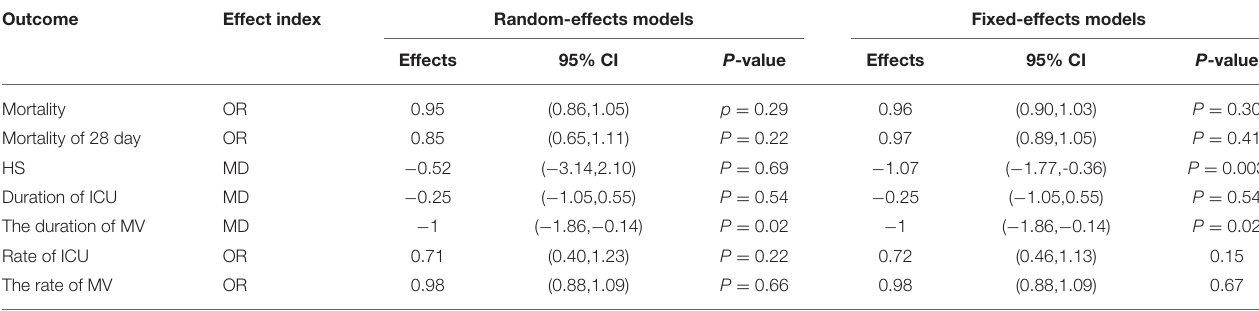
TABLE 2 | The sensitive